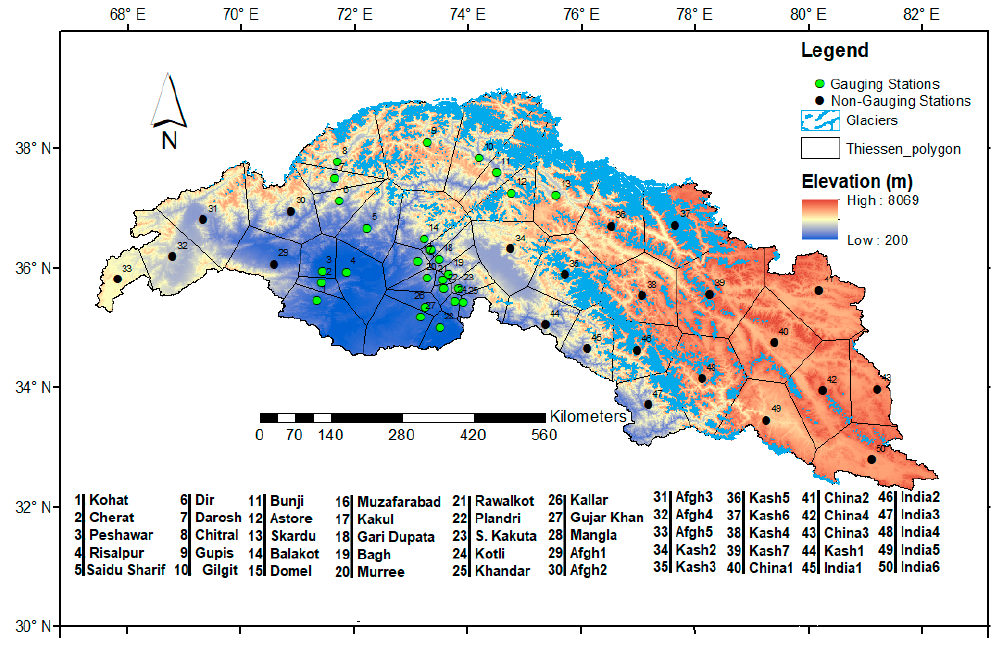
Figure 1. Location of the study area along with gauging and non-gauging stations.